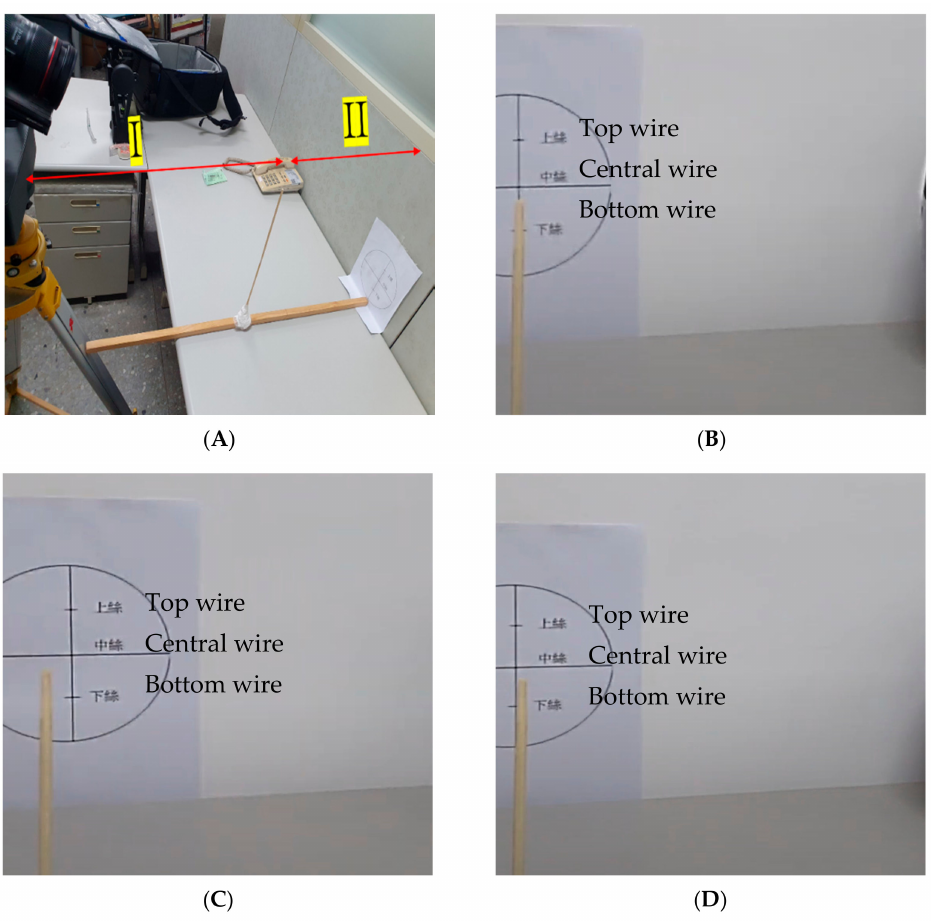
Figure 4. Developed field for calibration of eccentric issue between camera and panoramic instrument. ( A ) Calibrated field; ( B ) Non-eccentric issue; ( C ) Eccentric issue with left shift; ( D ) Eccentric issue with right